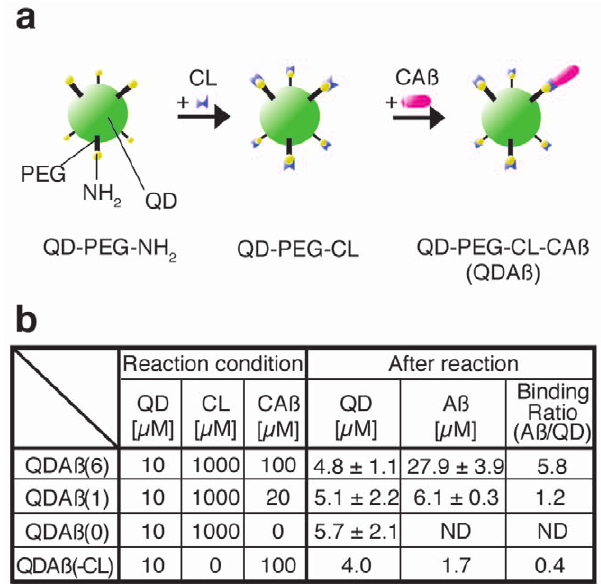
Figure 1. Preparation of QDA b . (a) Scheme of QDA b preparation. QD-PEG-NH 2 was mixed with crosslinker (CL) and incubated for 1 h at 22 u C. After elimination of unreacted CL by a desalting column, the intact QD-PEG-CL was mixed with various concentrations of Cys-A b 40 (CA b ) and incubated for 1 h at 22 u C. The maleimide group of CL was quenched by 2-mercaptoethanol, and unreacted CA b was removed by desalting columns. (b) Yield of QDA b preparation. The table shows reaction conditions and the yields of QD and A b .